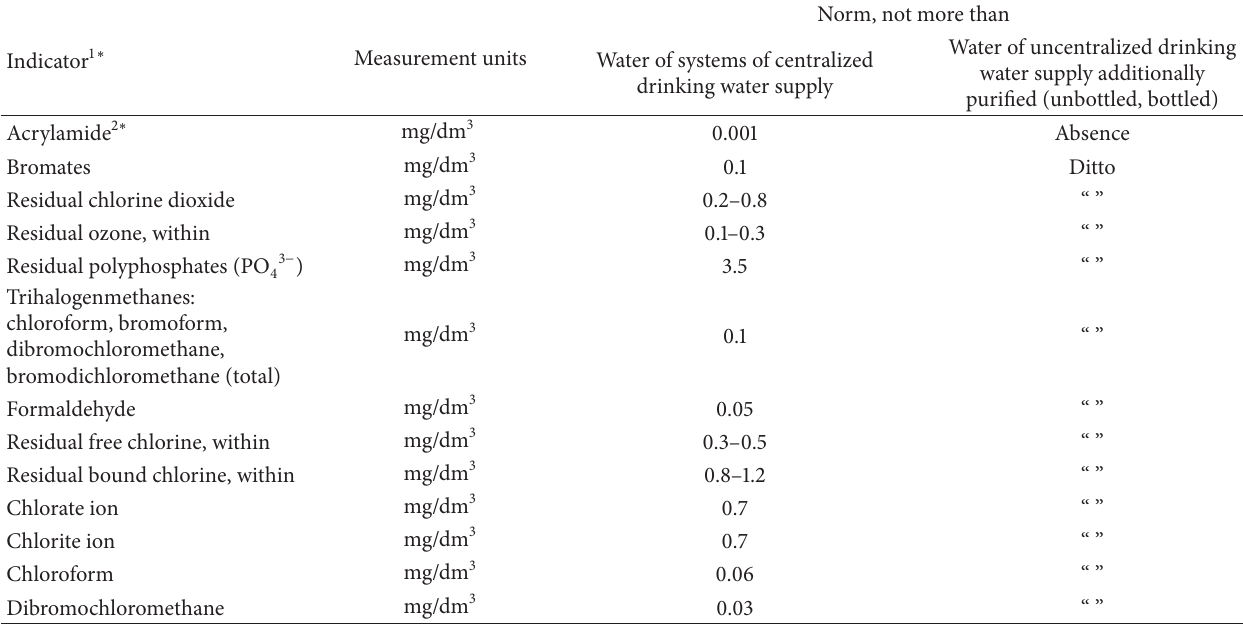
Table 7: Substances formed and getting into drinking water during water conditioning.